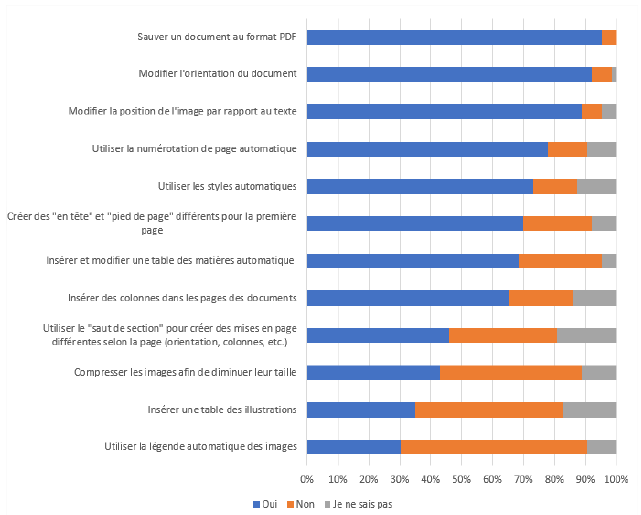
Fig. 4: Answers of 65 students enrolled in the course for the theme “Writing an academic document” (Test of